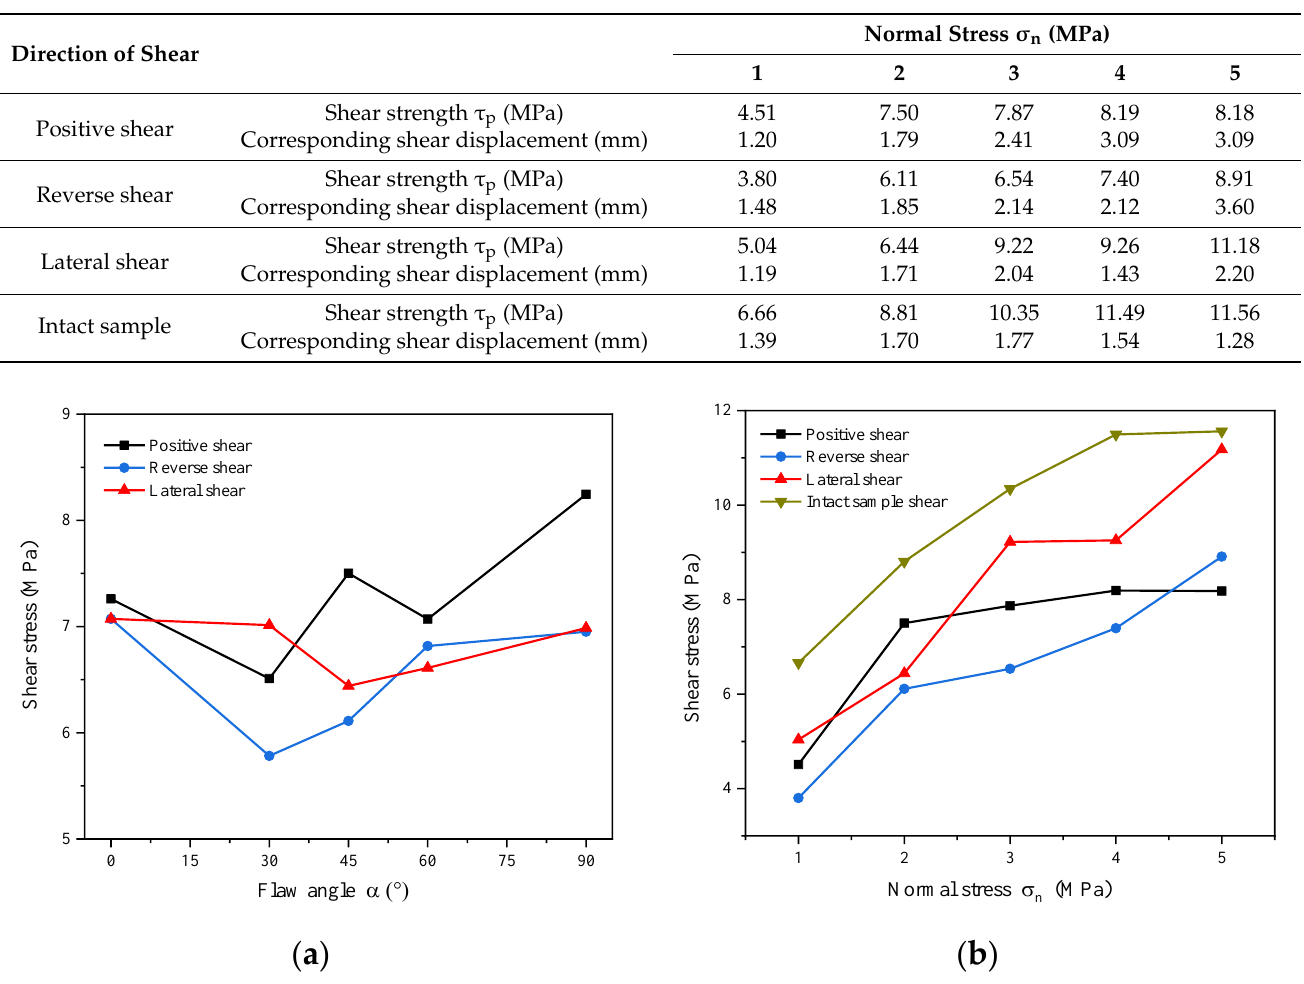
Table 4. Mechanical characteristics of the samples under different shear directions and normal stresses at the same flaw inclination angle ( α = 45 ◦ ).